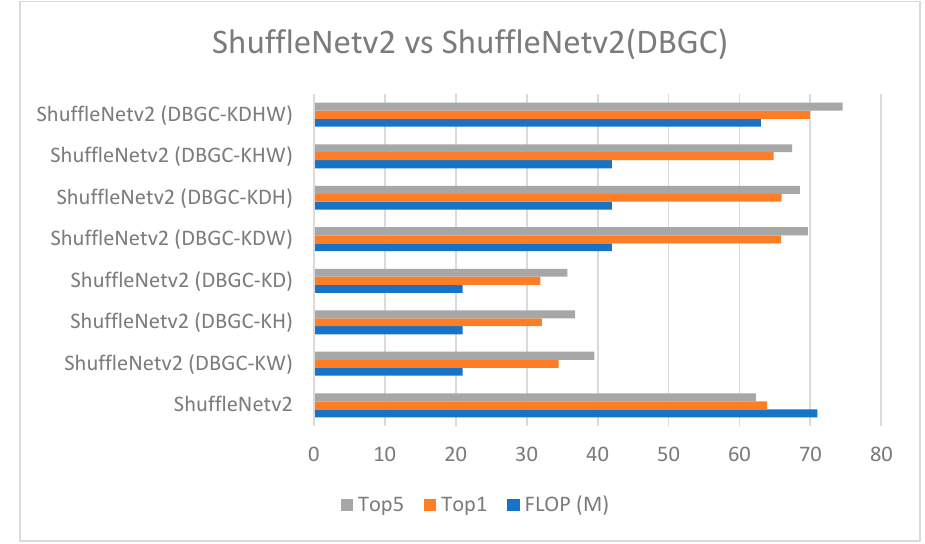
Figure 25. ShuffleNetv2 versus ShuffleNetv2 (DBGC).